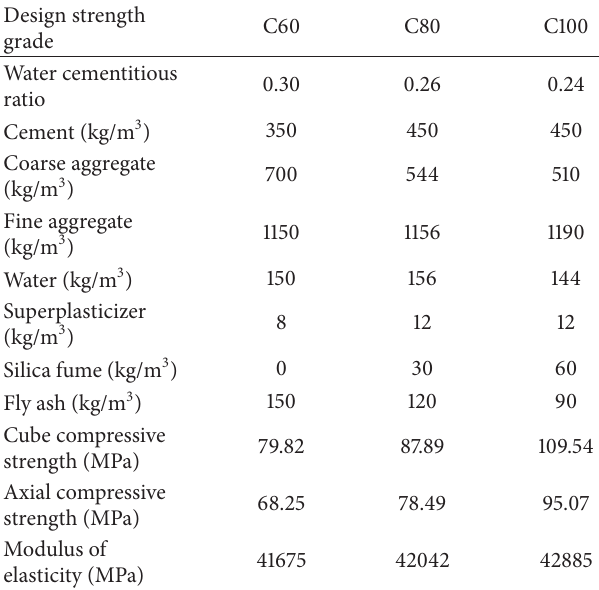
Table 2: Concrete mix properties and strength.